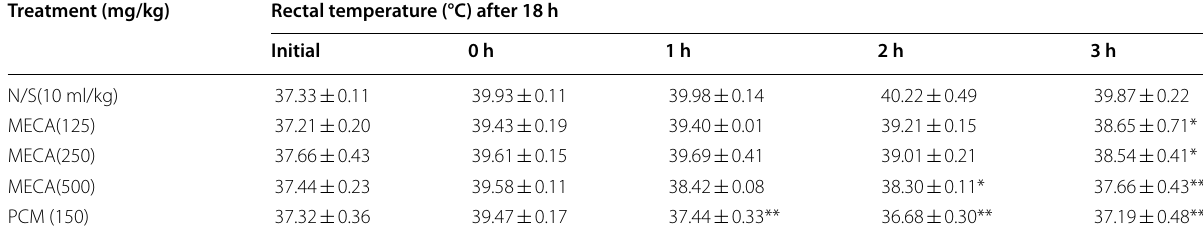
The values were analysed using repeated measure ANOVA followed by Bonferroni post hoc test and presented as mean N/S, normal saline; PCM, paracetamol; MECA, Methanol leaf extract of Culcasia angolensis * p 0.05, ** p 0.01 compared to control group; n ≤ ≤